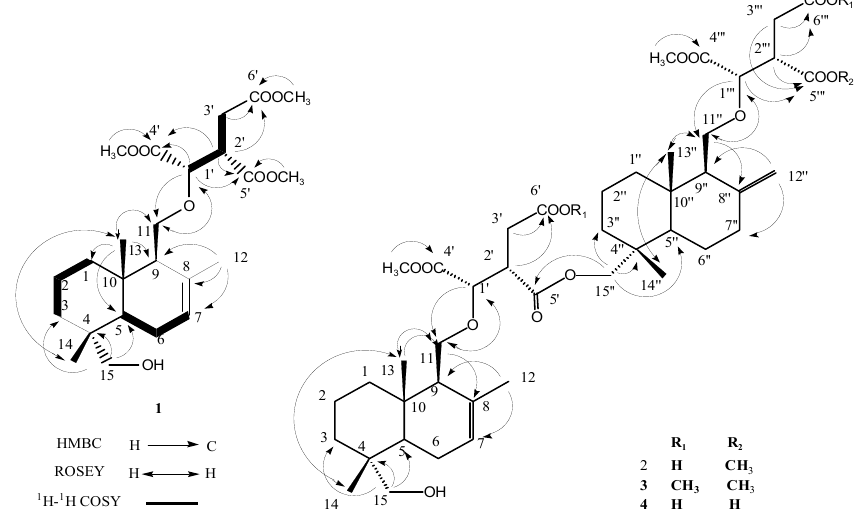
Figure 1. The structure of compounds 1 – 4 .